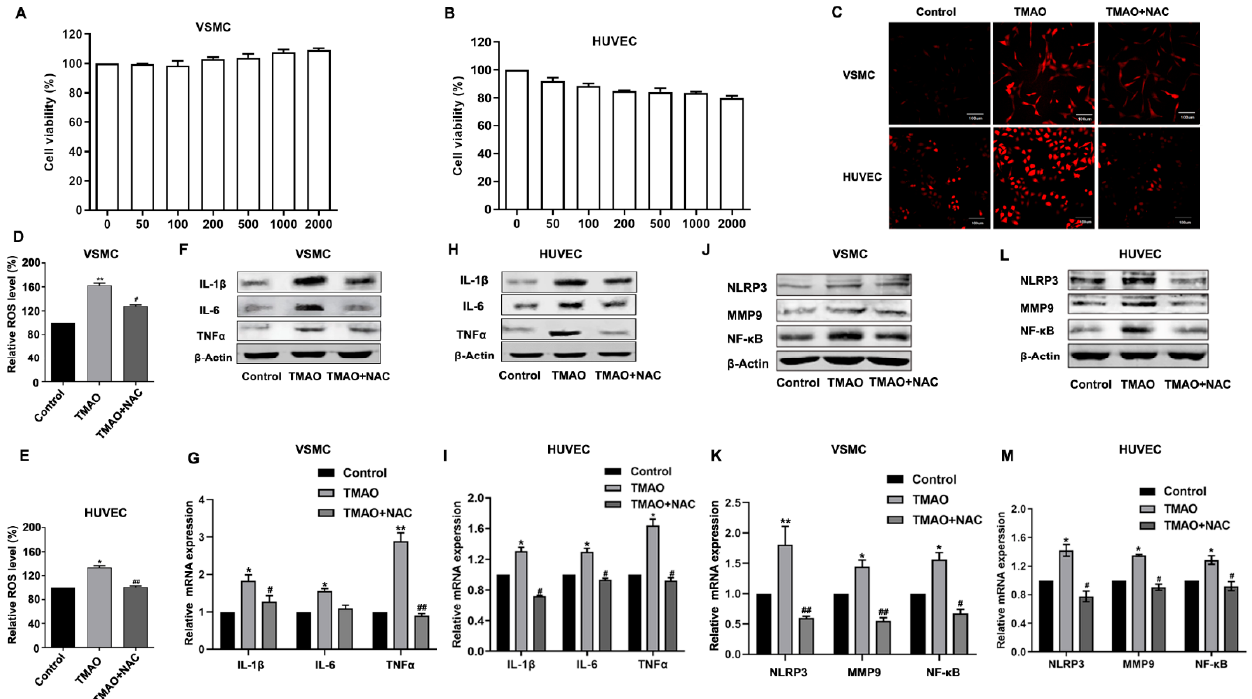
Figure 1. TMAO-induced inflammation via ROS in VSMCs and HUVECs. ( A , B ). VSMCs ( A ) and HUVECs ( B ) were incubated with different concentrations of TMAO (100, 200, 500, 1000 and 2000 µ M) for 24 h. Thereafter, the cell viability was determined. ( C – E ) VSMCs and HUVECs were treated with 1000 µ M TMAO for 24 h. The total ROS levels were determined by staining with DCFH-DA. Then, the ROS levels were observed by confocal microscopy ( C ) and measured by flow cytometry ( D , E ). ( F – M ) The protein levels ( F , H , J , L ) and relative mRNA levels ( G , I , K , M ) of inflammation-related markers IL-1, IL-6 and TNF α ( F – I ) and other inflammatory factors NLRP3, MMP9 and NF- κ b ( J – M ) in VSMCs ( F , G,J,K ) and HUVECs ( H , I,L,M ) were detected by western blot and quantitative real ‐ time PCR. The values are the mean ± SD; n = 3; one ‐ way ANOVA followed by a Tukey post hoc test. * p < 0.05; ** p < 0.01 vs. Control; # p < 0.05; ## p < 0.01 vs. TMAO group.